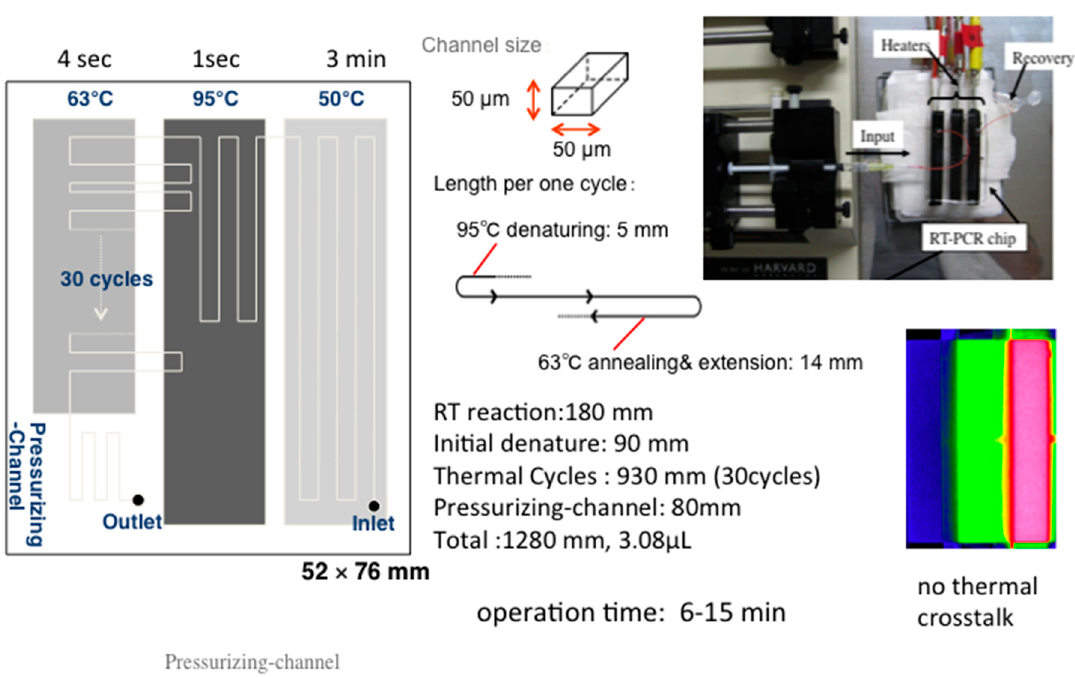
Figure 3. An RT-PCR micro flow chip: Electrochemical semi-real time detection of influenza virus RNA by RT-LAMP on a USB-powered portable potentiostat [46].